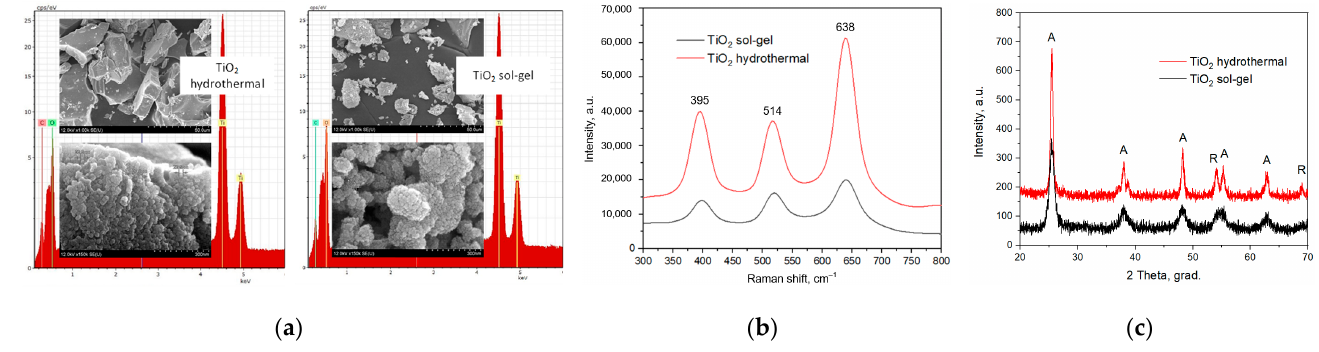
Figure 3. Results of structural characterization of TiO 2 nanoparticles: ( a ) SEM images and EDX spec- tra, ( b ) Raman spectra and ( c ) XRD patterns (A—anatase, R—rutile). spectra, ( b ) Raman spectra and ( c ) XRD patterns (A—anatase,